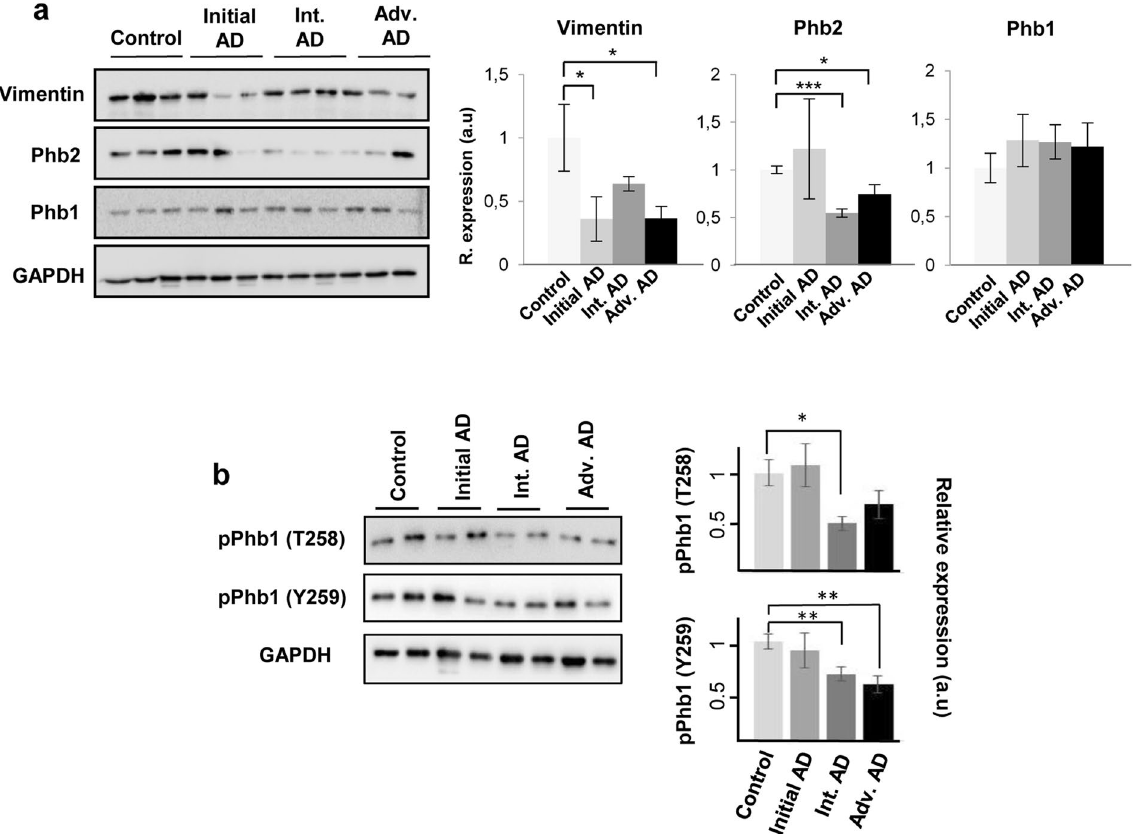
Figure 7. Olfactory expression of Vim and Phb subunits across AD stages. ( a ) Protein levels of Vim, Phb2, and Phb1 were monitored by Western-blotting. Equal loading of the gels was assessed by Ponceau staining and hybridization with a GAPDH specific antibody. Representative Western blot gels (n = 3/experimental group) are shown (left). Right panels show histograms of band densities. Data are presented as mean ± SEM from 3 independent OB samples per group. * P < 0.05 vs control group; *** P < 0.001 vs control group. ( b ) OB phosphorylation profiling of PHb1 across AD staging. Representative Western blot gels (n = 2/experimental group) are shown (left). Right panel shows histograms of band densities. Data are presented as mean ± SEM from 3 independent OB samples per group. * P < 0.05 vs control group; ** P < 0.01 vs control group. Full-length blots/gels are presented in Supplementary